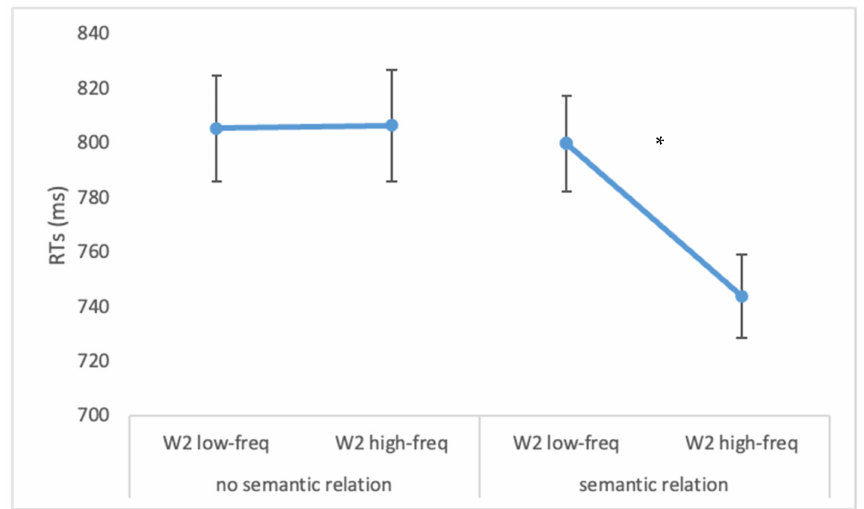
Figure 4. Reaction times for Experiment 2. The statistically significant interaction of semantic relation condition × W2 frequency is reported. Bars represent standard errors. The asterisk (*) indicates statistically significant